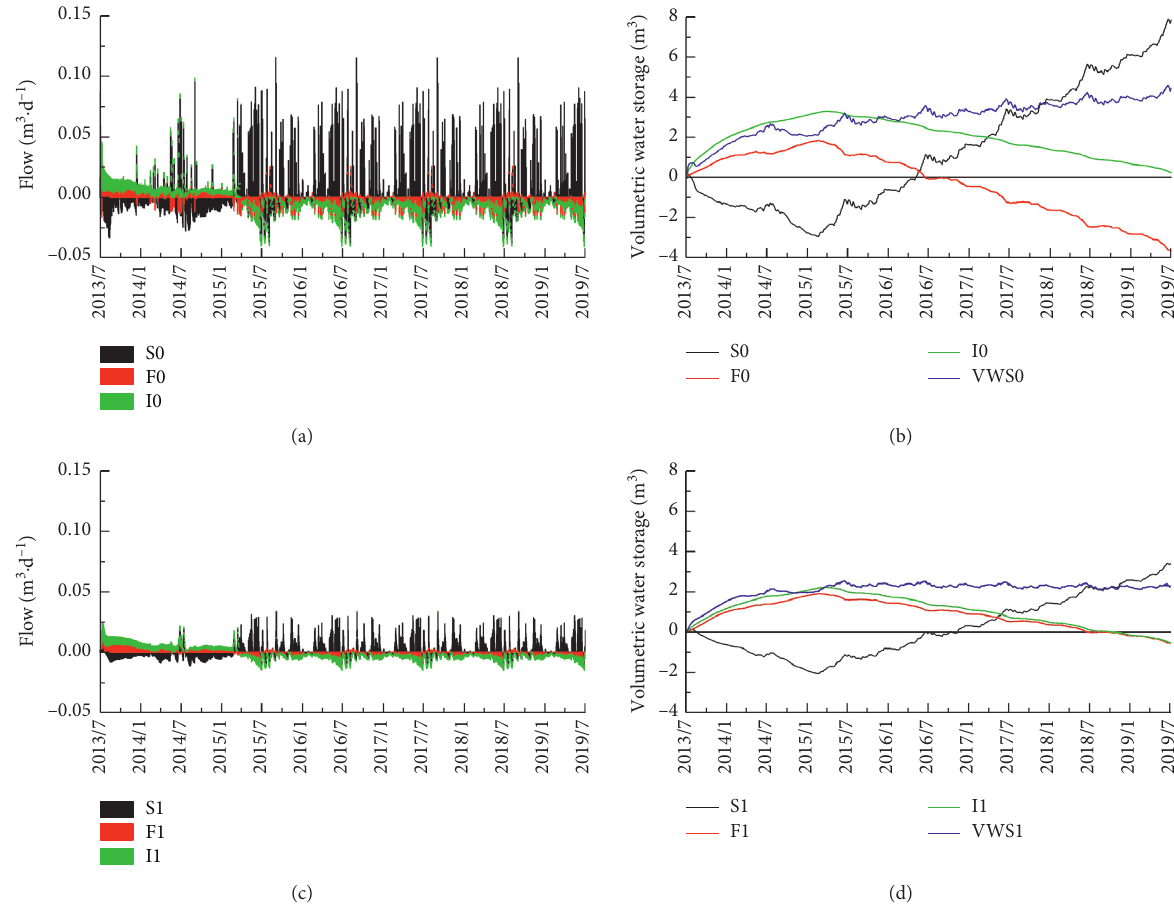
Figure 10: Calculated flow and volumetric water storage over time: (a) flow of cross-sections S0, F0, I0; (b) volumetric water storage of cross-sections S0, F0, I0, and S0+F0+I0; (c) flow of cross-sections S1, F1, I1; (d) volumetric water storage of cross-sections S1, F1, I1 and